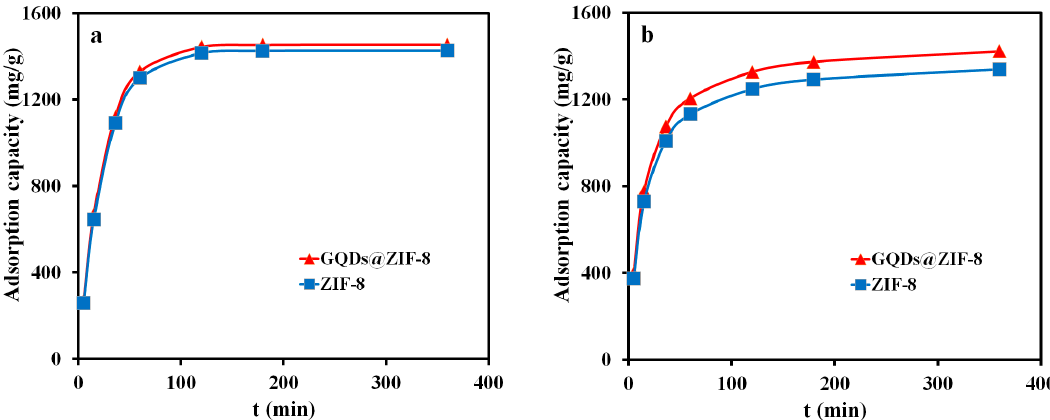
Figure 14. PFO ( a ), PSO ( b ) fitting curves of ZIF-8 and GQDs@ZIF-8 for ethyl acetate adsorption. Table 2. Adsorption kinetic parameters of ZIF-8 and GQDs@ZIF-8 for toluene adsorption.